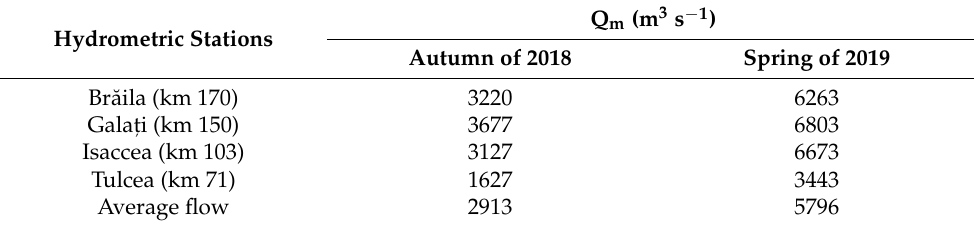
Table 8. Danube River mean discharge flows (Q m ) during autumn of 2018 and spring of